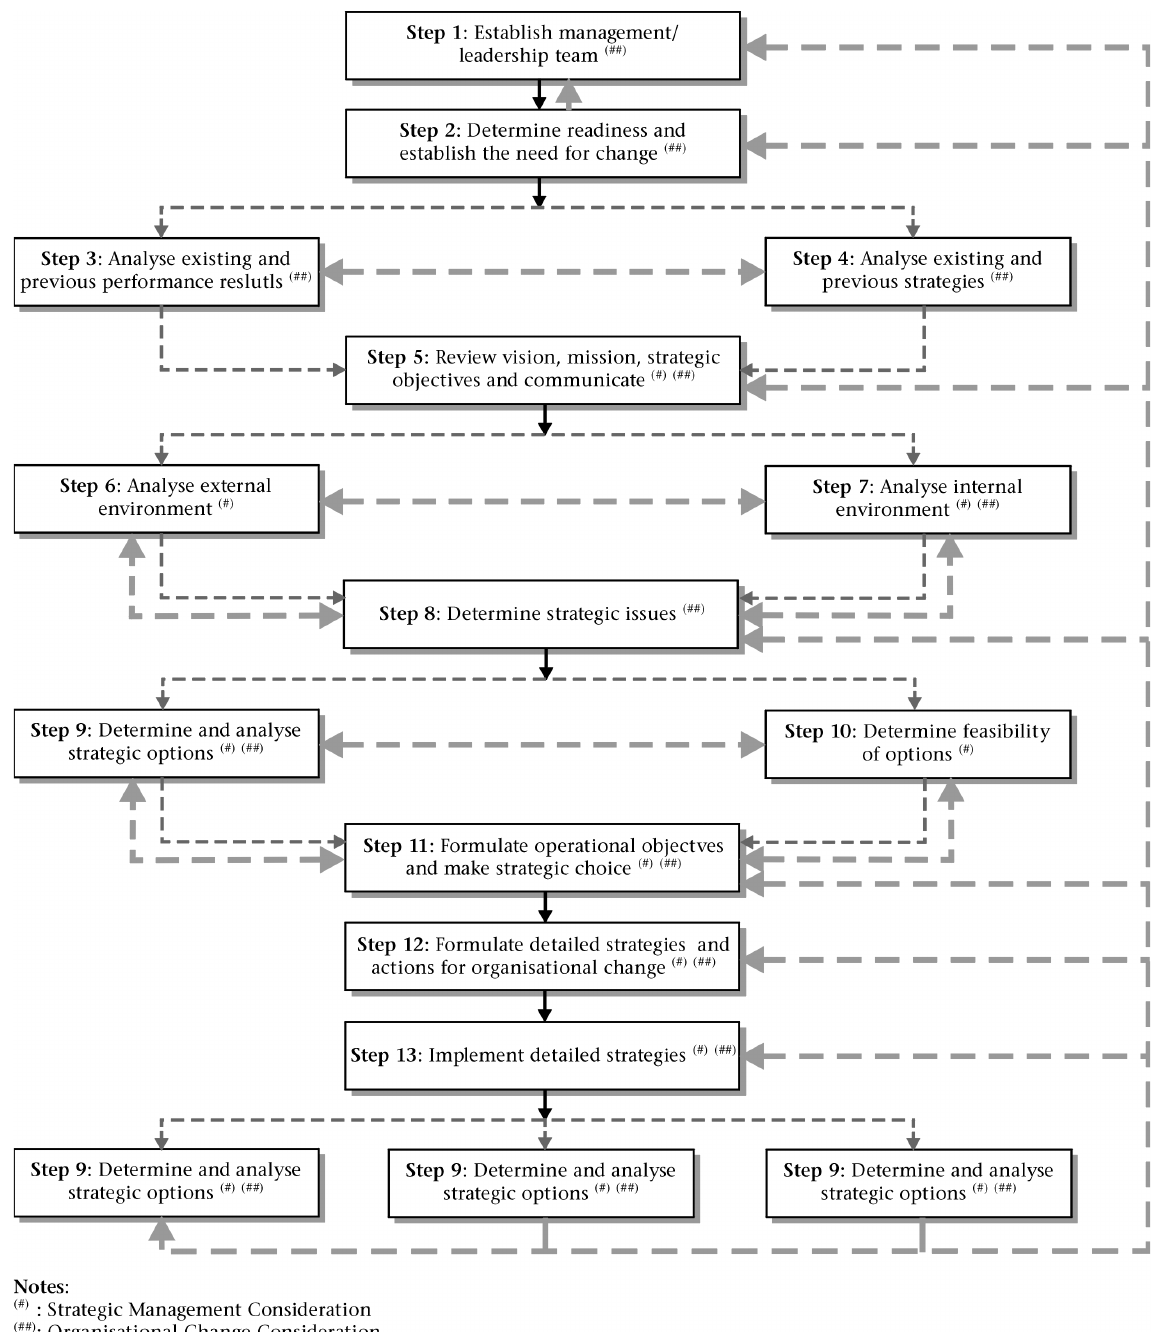
Figure 1: An Integrated Strategic Management Model to Manage Change in the Public Sector (Swanepoel,